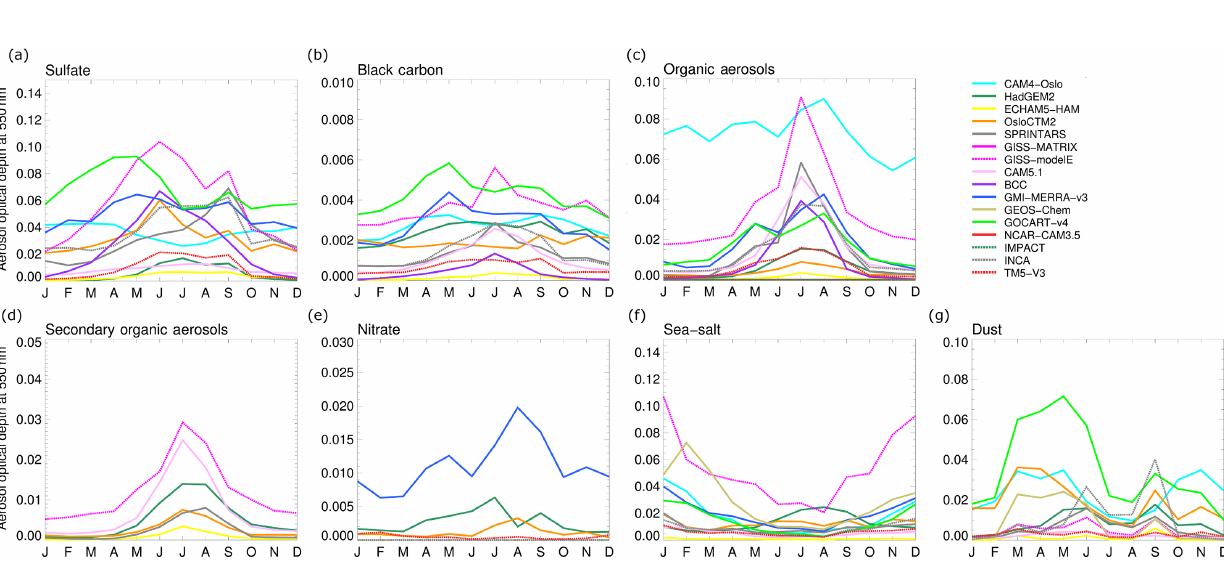
Figure 9. Seasonal cycle multi-model Arctic AOD for (a) sulfate, (b) BC (from all sources), (c) total OA (from all sources), (d) SOA, (e) nitrate, (f) sea-salt, and (g) dust. The Arctic region is defined as 60–90 ◦ N. Note the different